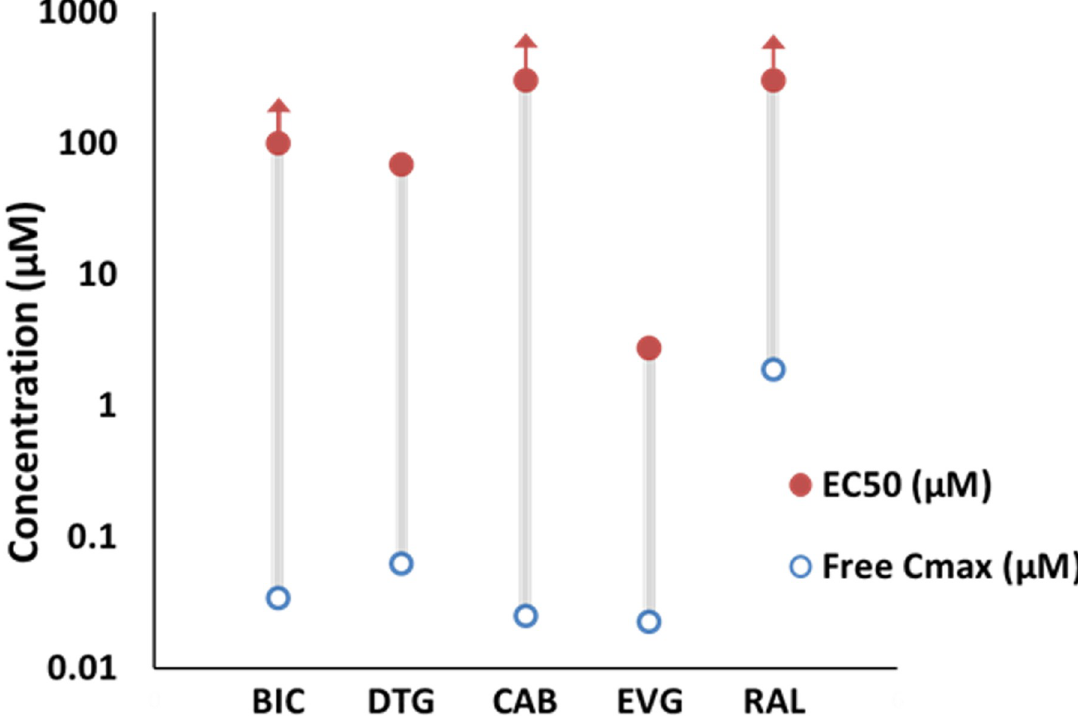
Fig 1. Depiction of MC4R antagonism assay results and clinical C max margins for INSTIs. Lines depict the substantial difference between the clinical dose C max value (protein-free) and the reported EC 50 value in the MC4R antagonism assay for each INSTI